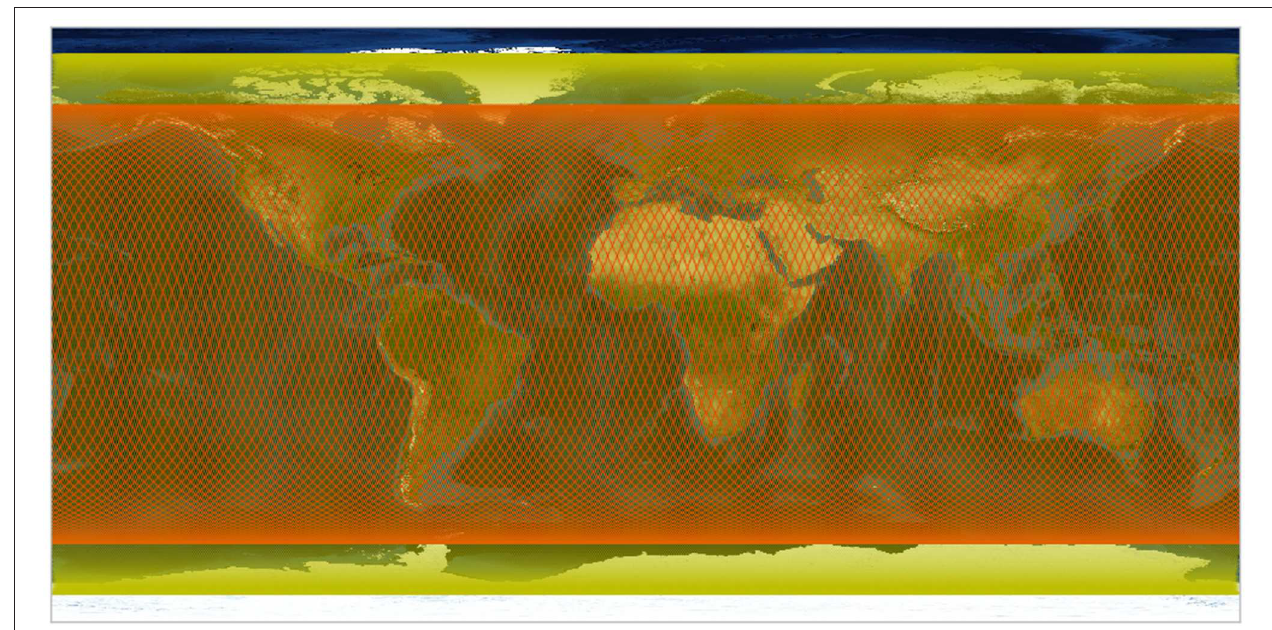
FIGURE 3 | Coverage of high-precision altimetry missions in repeat orbit (red curves correspond to Jason orbits, while yellow curves correspond to Envisat/SARALAltika orbits).